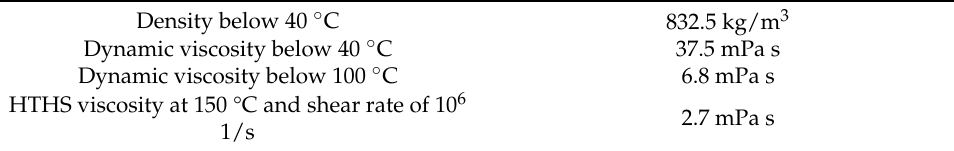
Table 5. Basic parameters of SAE 0W20 lubricating oil.